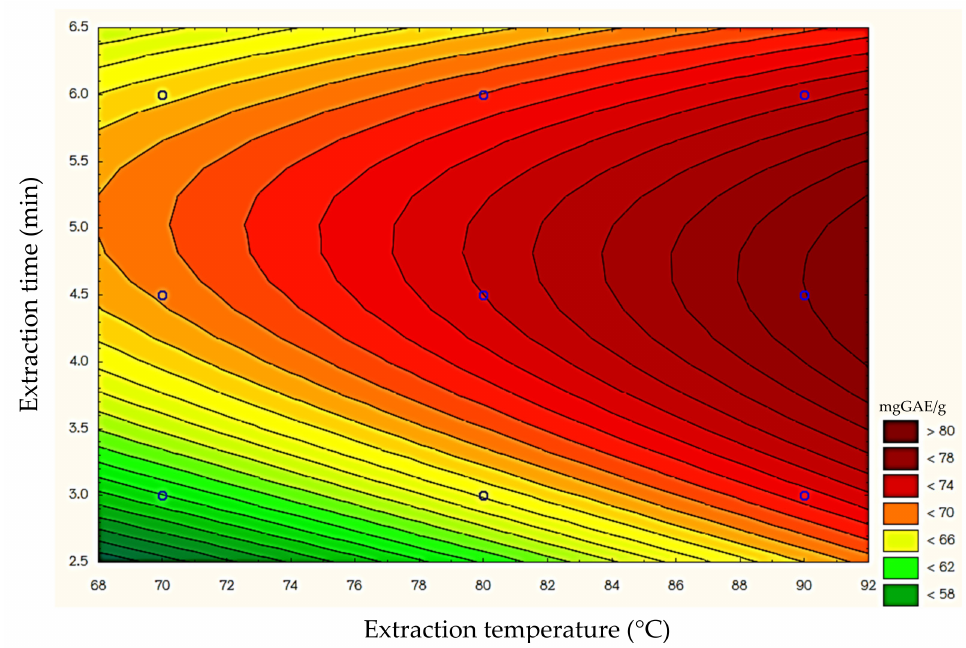
Figure 2. Contour plot for total polyphenol content as a function of extraction temperature and